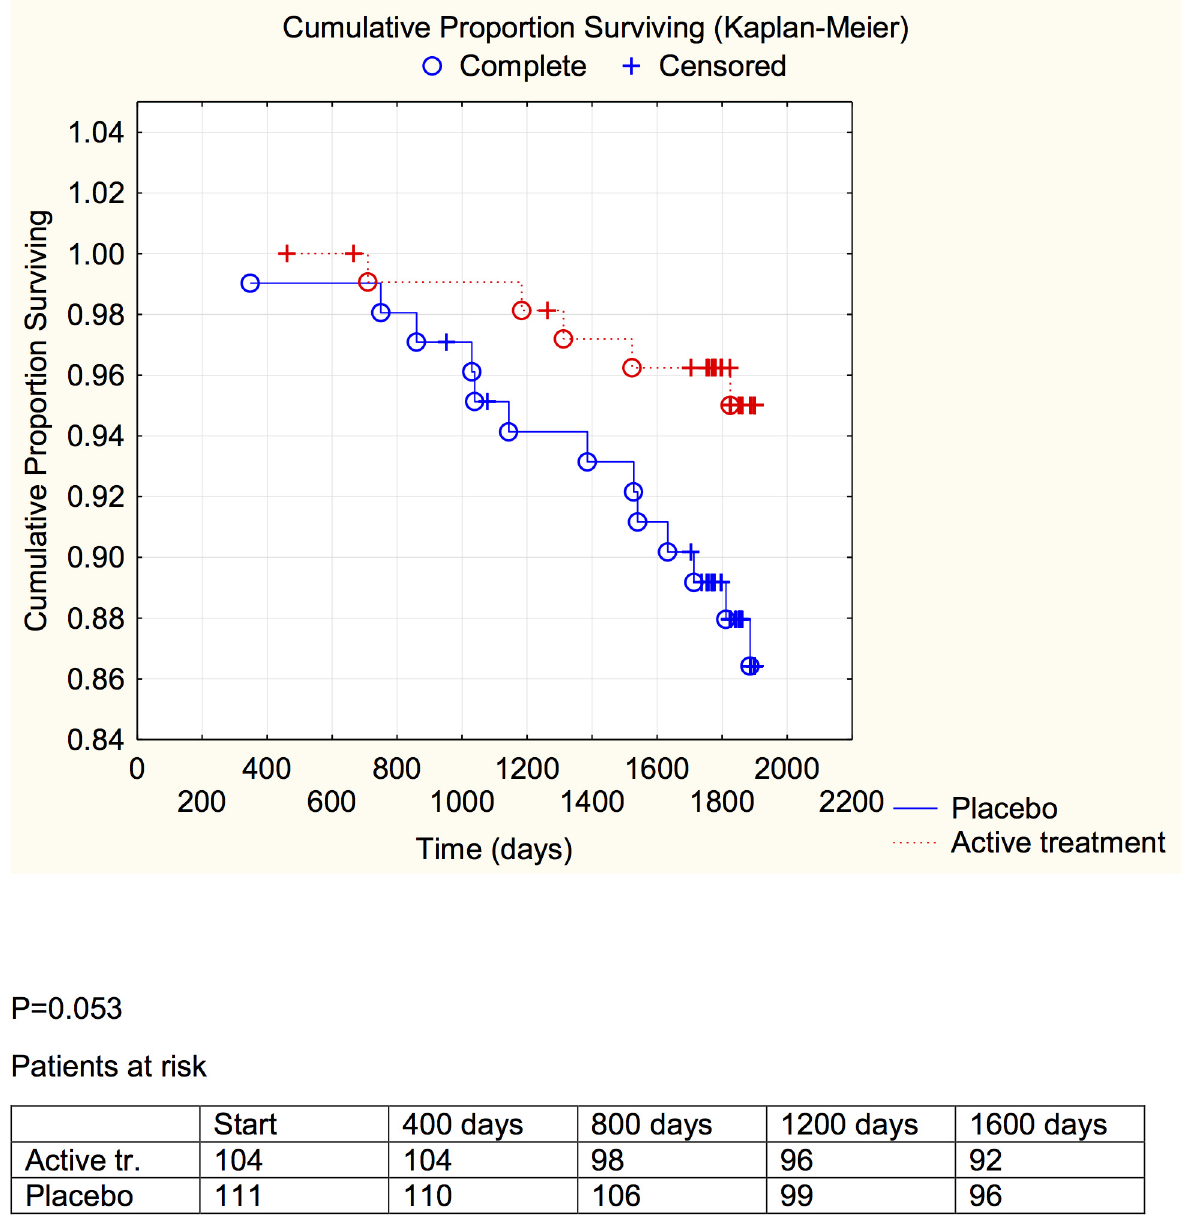
Fig 5. Distribution of cardiovascular mortality among those with a C-reactive protein concentration above median in those who received active supplementation of selenium and coenzyme Q10 combined versus placebo during follow-up of 5.2